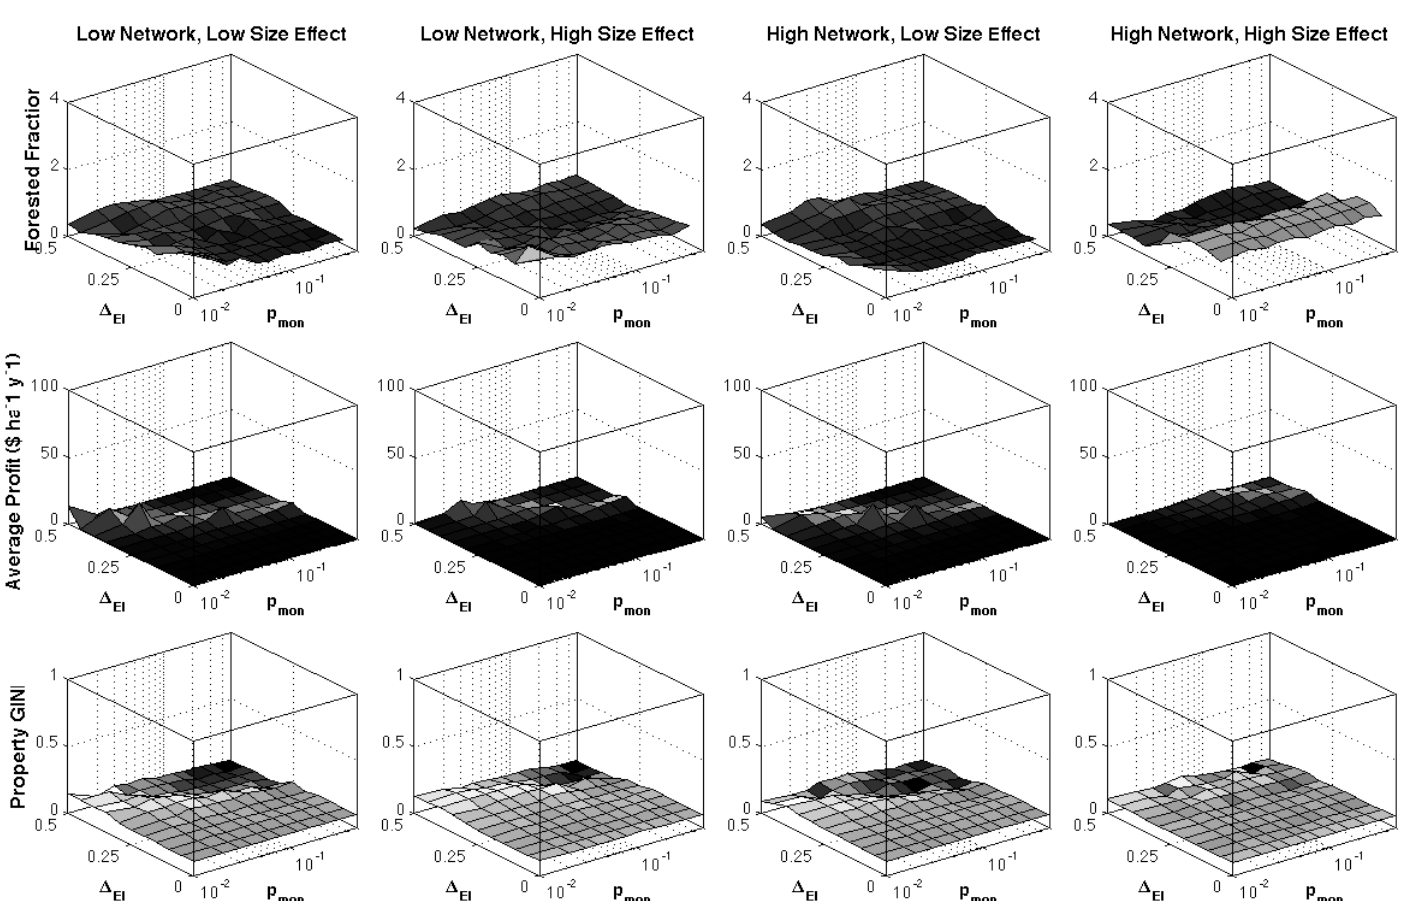
Figure A5.7: Standard deviations for response surfaces for Policy Scenario 3 – Sensitivity to change in expected income Δ EI and in monitoring probability p mon , non­tiered environmental licensing. Surfaces in row 1 show standard deviation for forested fraction across the landscape; row 2 shows standard deviation for profit per hectare of property per year; row 3 shows the standard deviation for level of land aggregation measured by the property GINI coefficient. Each column represents a different scenario of rancher interaction. Values reflect the standard deviation across n replicates, divided by the mean across the n